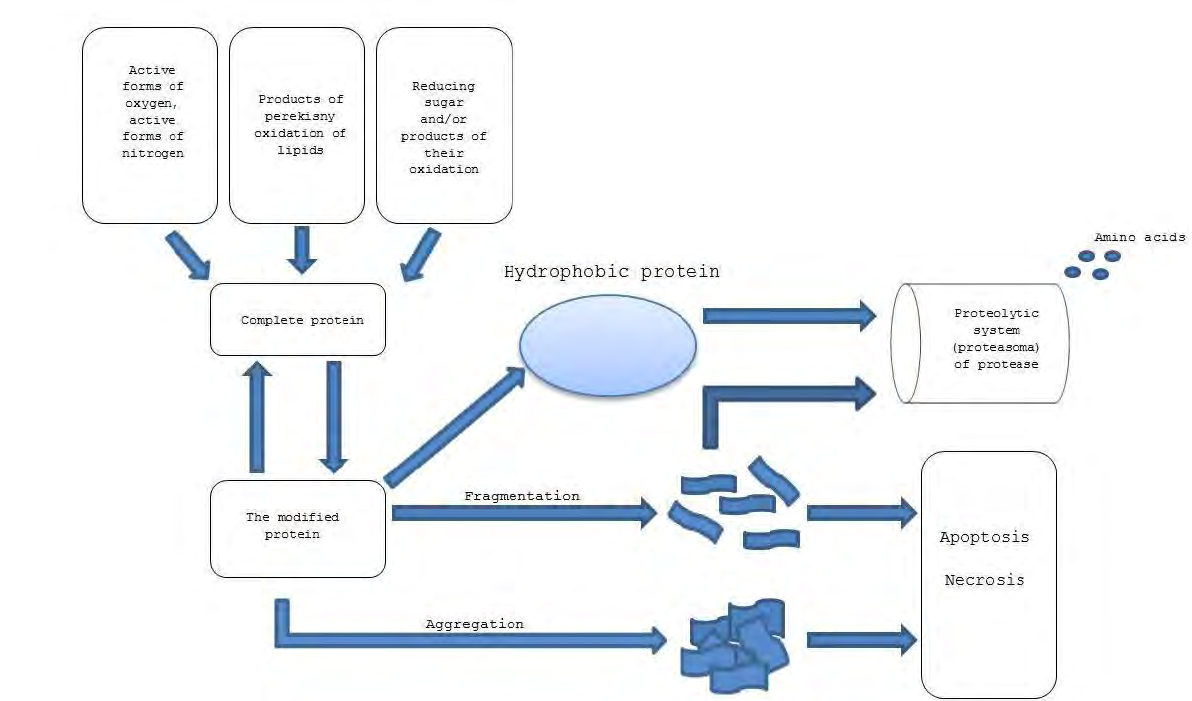
Fig. 2. Ways of formation and utilization of modified proteins by Davies, K.J. [18] Under effect of oxygen active forms two processes can take place: fragmentation of proteins, whose markers are aldehyde dinitrophenylhydrozones (ADNPH); aggregation of proteins, whose markers are ketone dinitrophenylhydrozones (KDNPH)